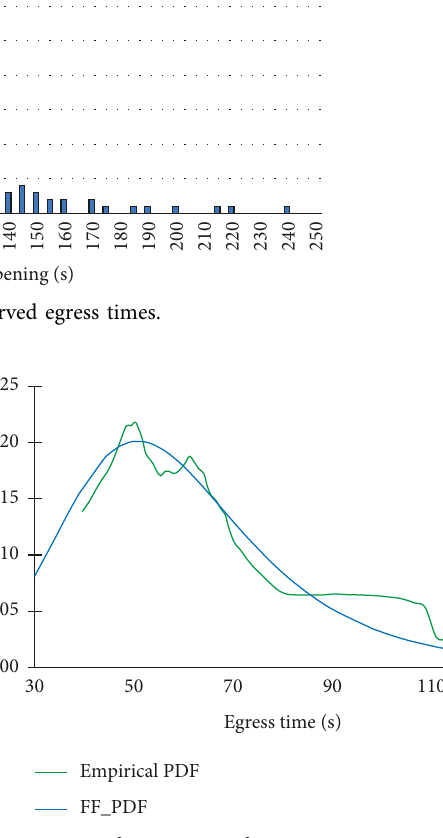
Figure 5: PDF of egress times for a train at 18:35. Note: empirical data are obtained by applying a sliding window over 10 egress times. FF means “free